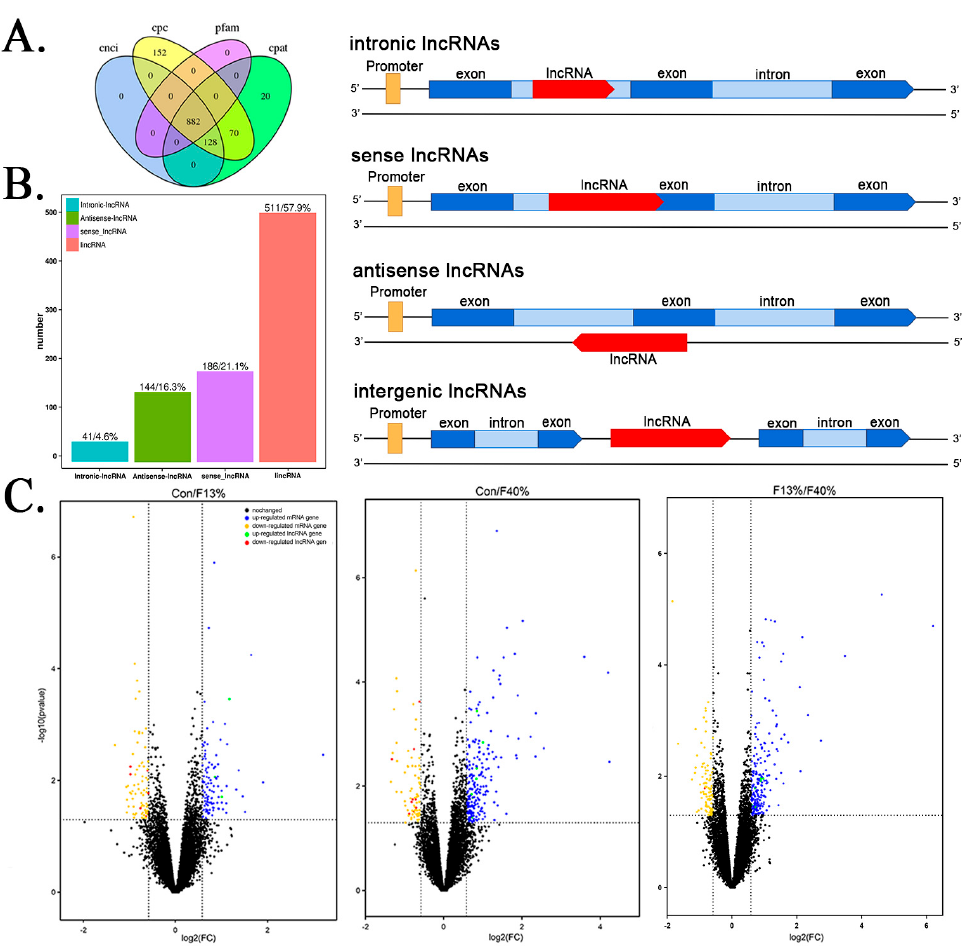
Figure 2. Overview of lncRNAs and different structures and expression between long non-coding RNAs (lncRNAs) and mRNAs. ( A ) Venn diagram of four lncRNA screening methods. ( B ) Classification of lncRNAs based on their genomic location. ( C ) Volcano map of the differentially expressed mRNAs and lncRNAs in the control group compared with 13% fructose group (Con/F13%), control group compared with 40% fructose group (Con/F40%), and 13% fructose group compared with 40% fructose group (F13%/F40%).